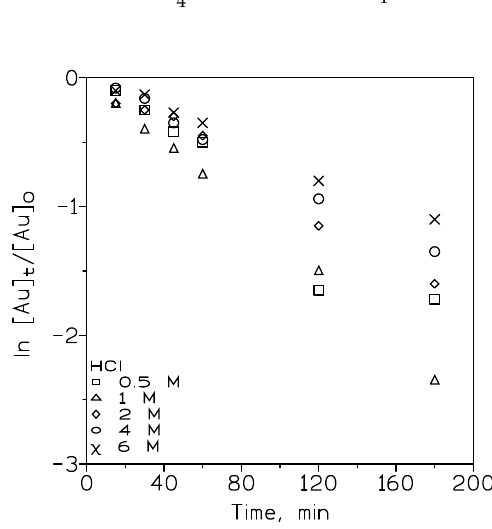
Figure 1. Influence of the HCl concentration on the permeability of gold(III) as a function of the ln [Au] t / [Au] 0 feed phase: 0.01 g / L Au(III) in HCl. Membrane phase: 0.23 M ionic liquid in Solvesso 100 on Durapore support. Receiving phase: 0.1 M NaSCN.